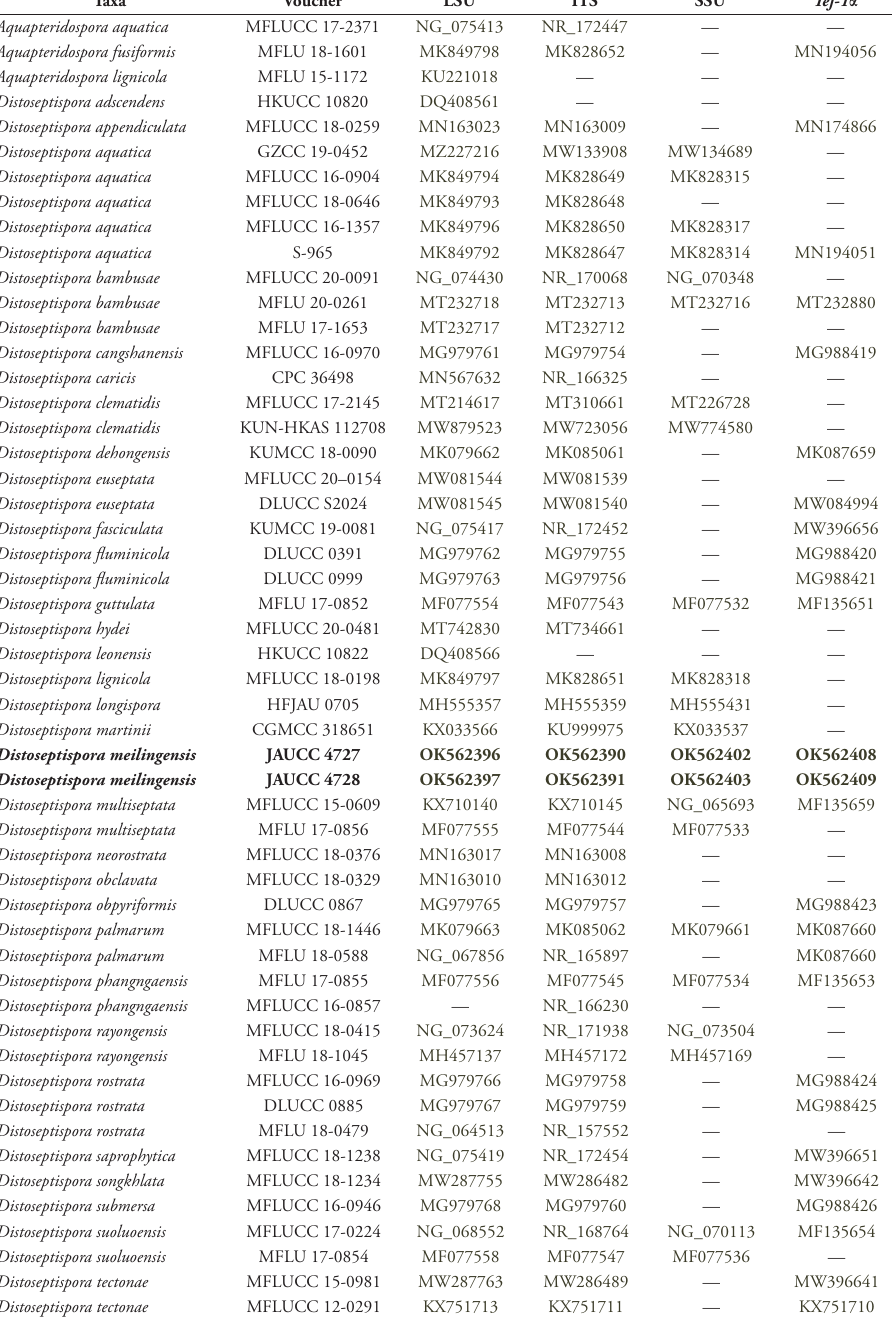
Table 1. Sequences used in this